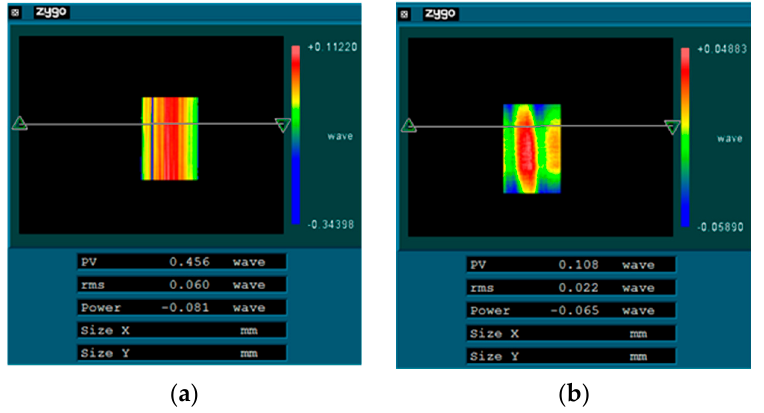
Figure 15. Wavefront comparison of 79 g/mm mid-step grating before and after error compensation: ( a ) no error compensation; ( b ) with error compensation. ( a ) no error compensation; ( b ) with error